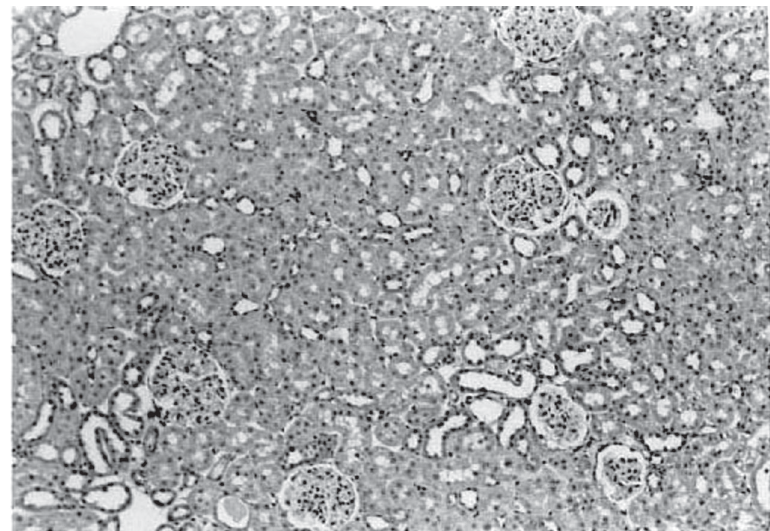
Figure 2. Immunohistochemistry for myoglobin in rat 13 (group III, anti-ICAM-1). Note the absence of myoglobin in Bowman’s capsule and in the tubular lumina, either as casts or as traces (immunohistochemistry, 100X).